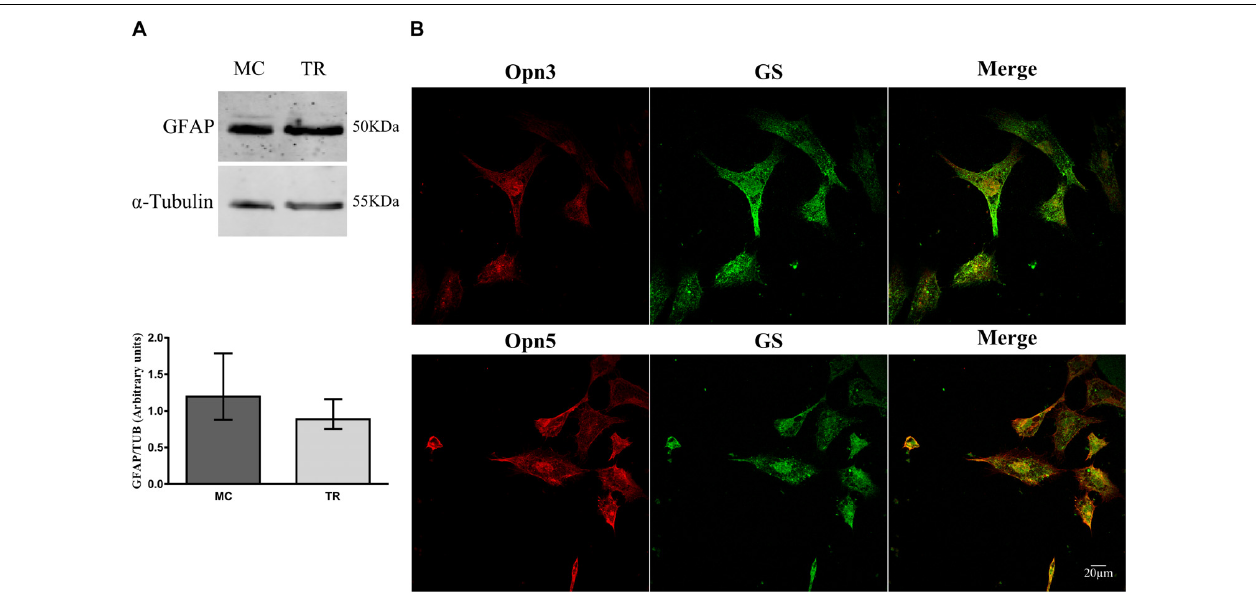
FIGURE 3 | Characterization of primary cultures of Müller glial cells. (A) Analysis of GFAP levels by WB in primary cultures of Müller glial cells and of total retina (TR) prepared at E8, immunoblots show bands at ∼ 50 kDa. The histograms show the median with range for GFAP levels in primary cultures of MC and TR ( n = 4/group). Primary cultures were highly enriched in Müller glial cells as defined by morphological cell identification (non-neuron-like morphology) and glial marker expression. (B) Primary cultures of Müller cells were labeled for Opn3- or Opn5- (red) and GS-like proteins (green) and visualized by confocal microscopy. Müller cells showed ubiquitous and generalized localization of Opn3 and Opn5. Scale bar = 20 µ